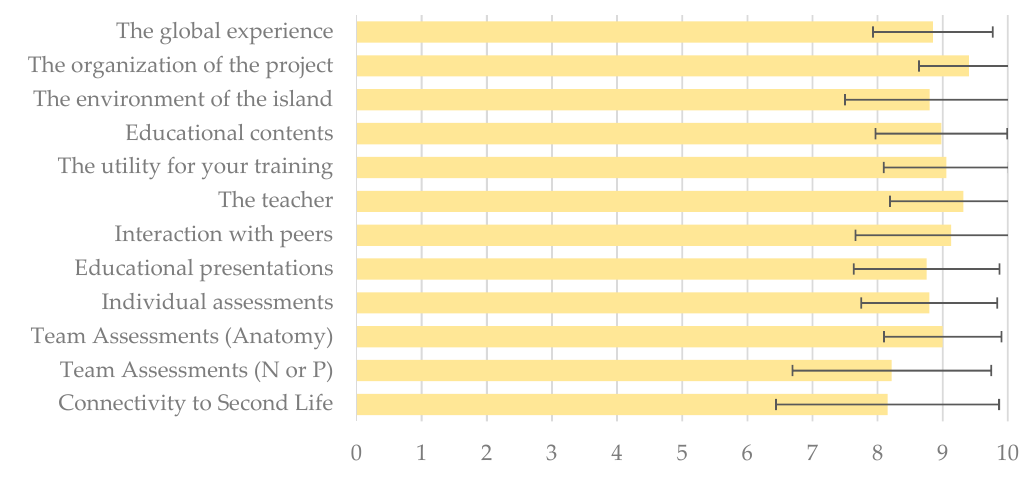
Figure 2. Bar graph depicting the mean rating of various aspects of the League of Rays game scored on a scale of 0 to 10. Error bars represent standard deviation. N or P means normal or